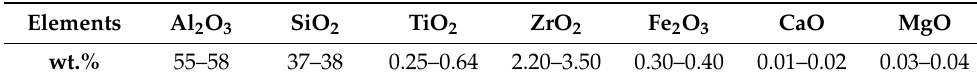
Figure 1. SEM image of particles: ( a ) sillimanite, ( b ) B 4 C. Sillimanite is the compound of aluminium, silicon and oxygen having the chemical formula of Al 2 SiO 5 . Table 1 shows the details of the chemical composition of the primary reinforcement. Sillimanite is available in different colours, in the southern part of India mostly in a brown colour. Sillimanite is chemically inert and stable, therefore it is used as a primary reinforcement material (purchased from VV Minerals, Tirunelveli, India). Table 1. Sillimanite chemical composition.